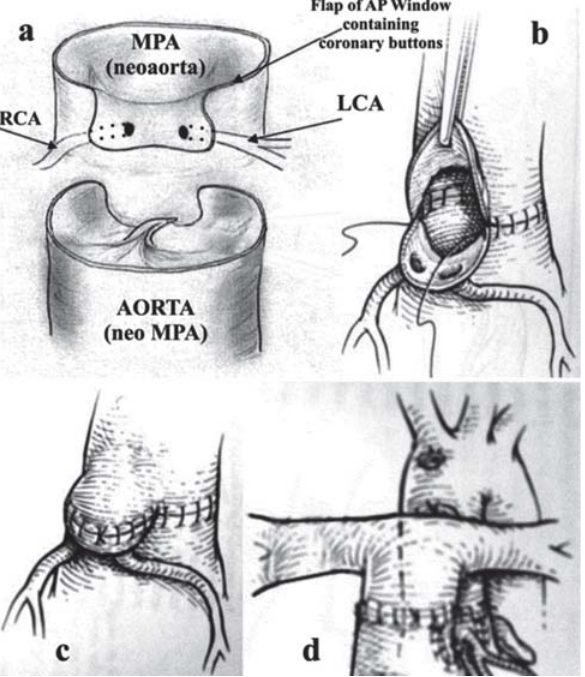
Fig. 2 - (a) Transection of great vessels at the level of aortopulmonary window with both the coronaries mobilized on a single button in continuity with the window. (b) and (c): Neo-aortic reconstruction by direct anastomosis of the shelf of aortopulmonary window containing the coronary button with the distal ascending aorta without using any patch. (d): Completed repair. RCA –